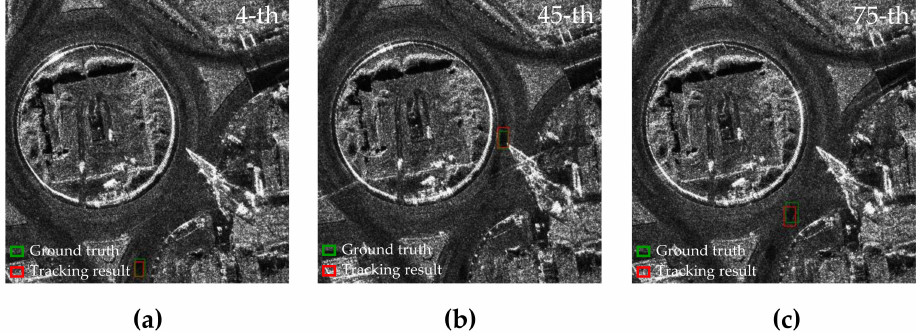
Figure 24. Tracking results of another real Video-SAR data: ( a ) 4th frame; ( b ) 45th frame; ( c ) 75th